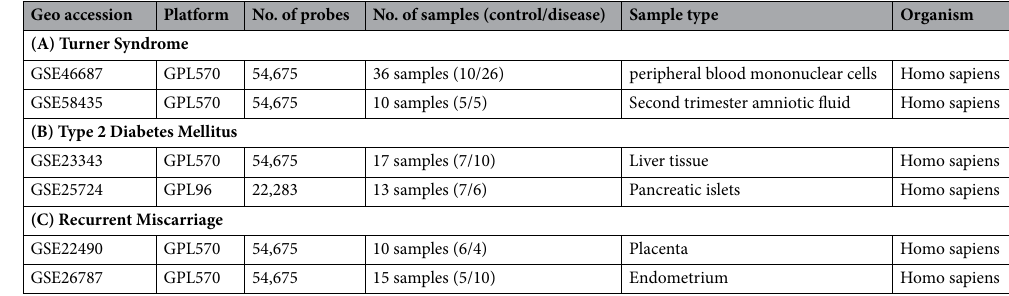
Table 1. Microarray datasets of (A) Turner Syndrome (B) Type 2 Diabetes Mellitus (C) Recurrent Miscarriage.